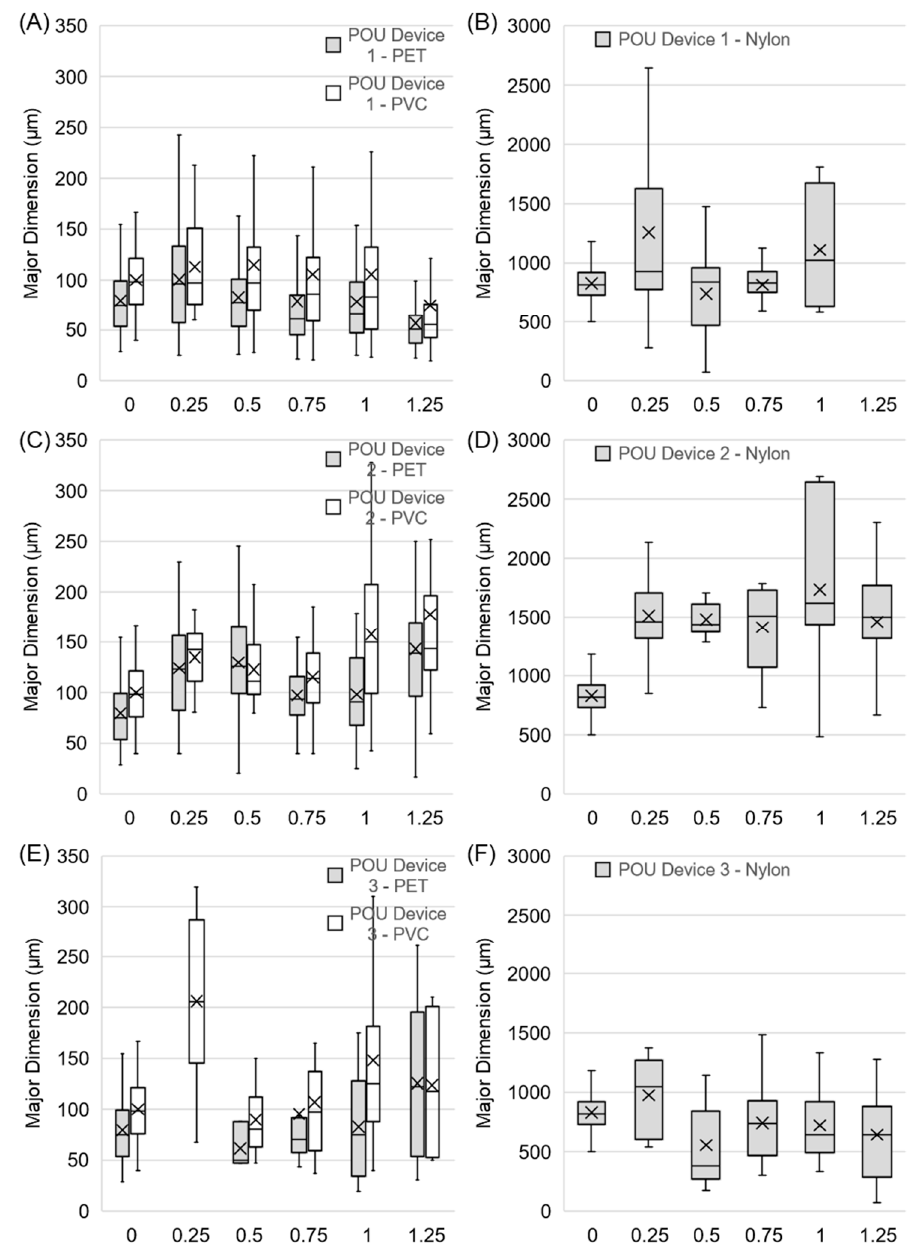
Figure 4. Change in size distribution of the major dimensions of PET, PVC, and nylon microplastics as a function of the increasing rated treatment capacity for all three POU devices. X represents the mean and lines represent the maximum, 3rd quartile, median, 1st quartile, and minimum values, from top to bottom.